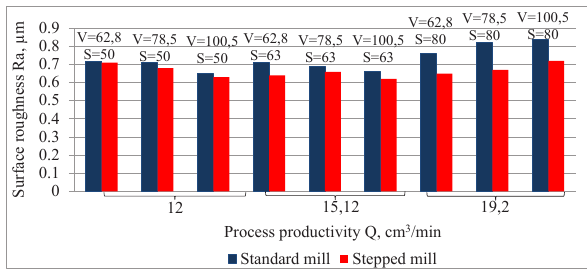
Fig. 3 . Influence of cutting modes on surface roughness and process productivity (V – m/min, S – mm/min)